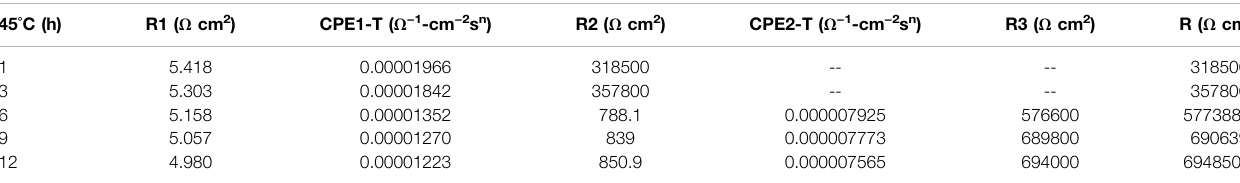
TABLE 5 | Impedance fi tting data of base metal area soaked in arti fi cial seawater at 45 ° C for 12 h 45 ° C